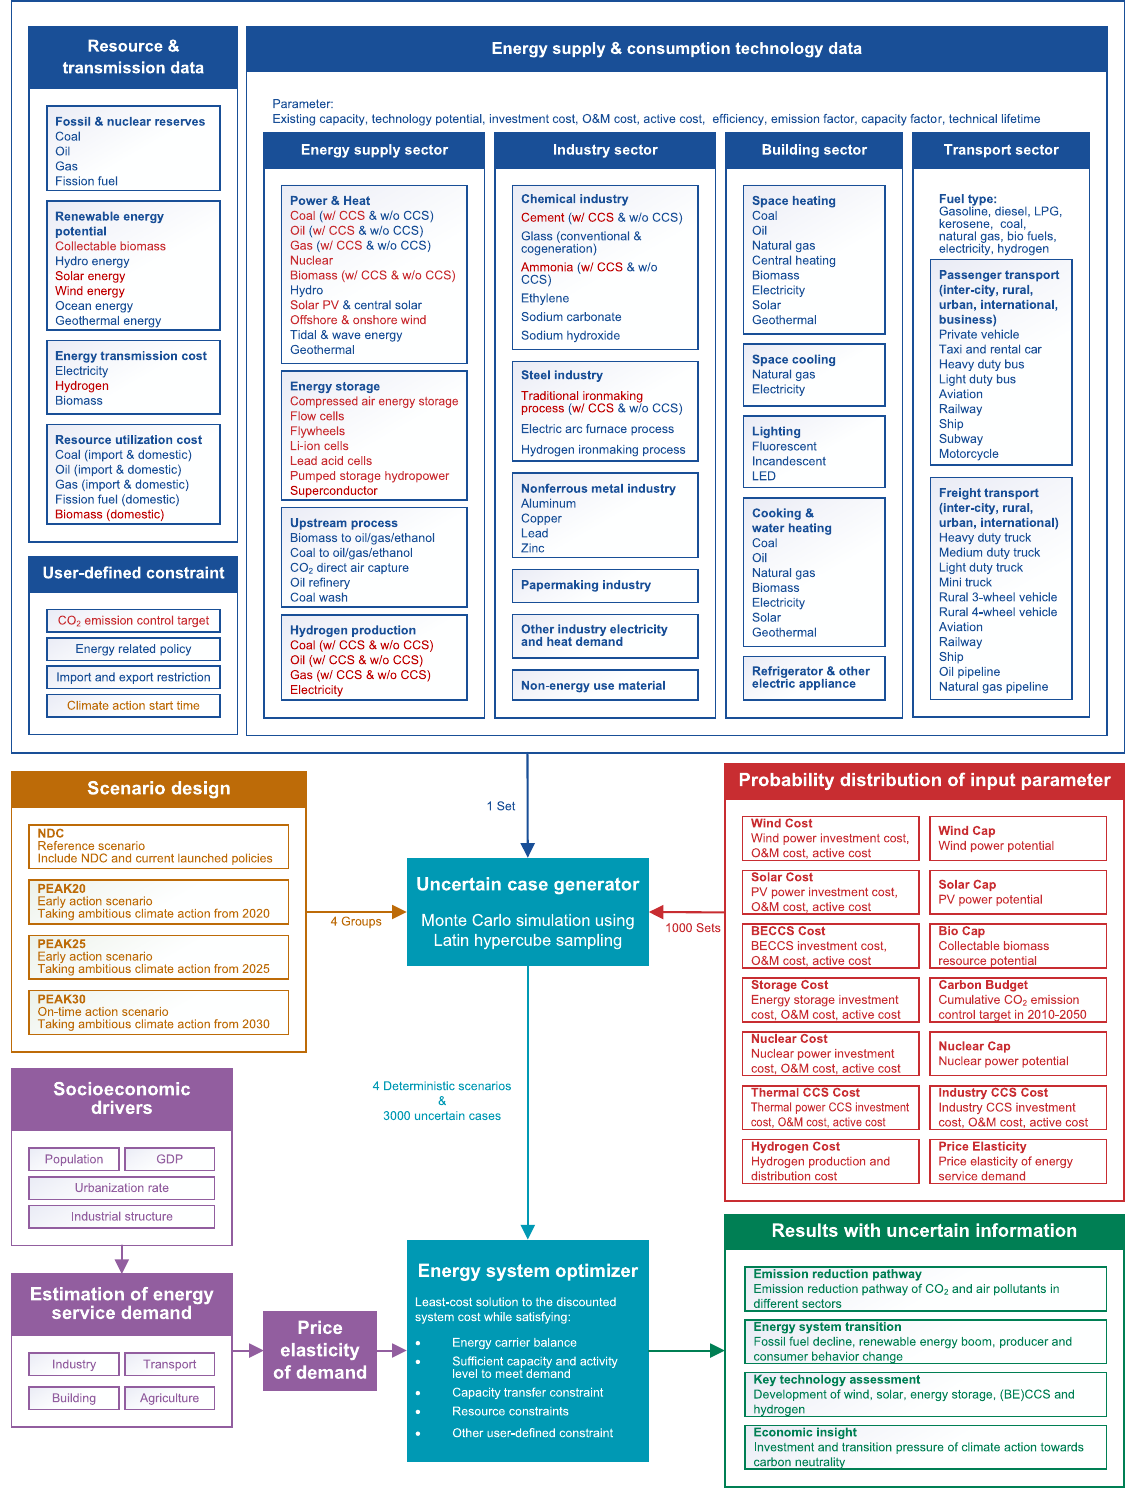
Fig. 1 China-TIMES-MCA structure. This fi gure shows the necessary information about the China-TIMES-MCA model. The cyan part is the uncertain case generator and energy system optimizer. The blue part shows the parameters obtained from the statistical data and literature for the intermediate case. The brown part illustrates the scenario design of the study. The purple part is the end-use demand considering price elasticity. The red part is the fourteen input parameters with the corresponding probability distributions. The green part is the model result, which corresponds to the main fi ndings in this paper. In this fi gure, w/ CCS means that this technology is equipped with carbon capture and storage, while w/o CCS means that it is not equipped.